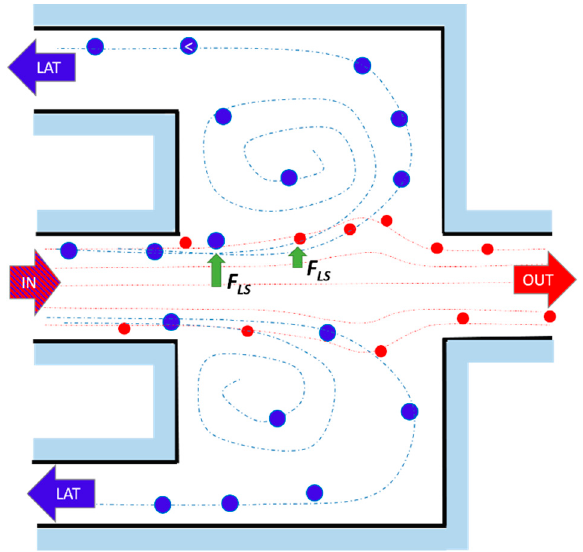
Figure 7. Scheme of the size-selective separation in micro-chambers with three outlets proposed by Wang and Papautsky [88]. At the chamber entrance, the particles are arranged in a two-focus position near the channel walls. The large particles (blue) undergo a larger shear-gradient induced lift force, being pushed in the chamber and exiting through the two later outlets (LAT), while the smaller particles (red) remain in the main channel exiting through the main outlet (OUT). The dashed paths indicate the fluid streamlines followed by the big (blue) and small (red) particles. Adapted from [88].